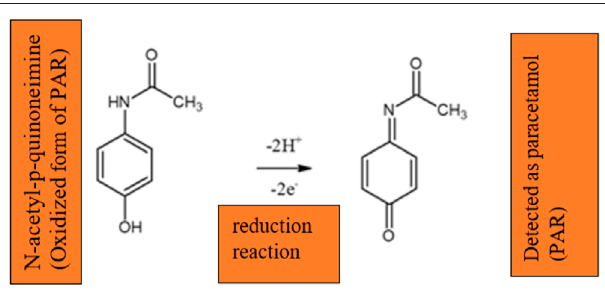
SCHEME 2 | The mechanism for the detection of PAR using gCN- AgPVP